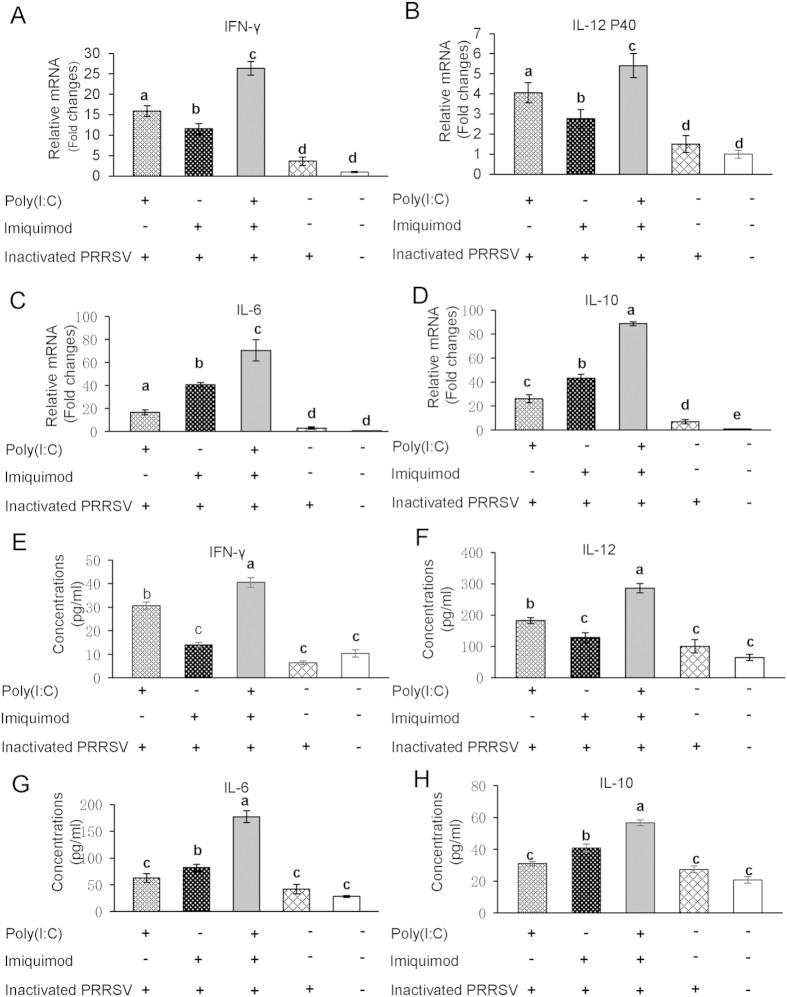
The mRNA and protein levels of cytokines in MoDCs stimulated with TLR ligands and inactivated PRRSV antigen.MoDCs were incubated with poly (I: C) and/or imiquimod along with inactivated PRRSV antigen for 12 h, the inactivated PRRSV antigen and RPMI-1640 were used as control. The transcript levels of Th1-type cytokines IFN-γ (A) and IL-12 P40 (B), Th2-type cytokines IL-6 (C) and IL-10 (D) were analyzed by real-time RT-PCR. Relative transcript levels are shown as fold changes relative to the level for the control cells of the RPMI-1640 group. Concentrations of Th1-type cytokines IFN-γ (E) and IL-12 (F), Th2-type cytokines IL-6 (G) and IL-10 (H) in the supernatants of MoDCs were detected by ELISA. The data represent the means of three independent experiments, with each experiment performed in triplicate. Data represent the means ± standard deviations (error bars) of three independent experiments. Different letters (a–e) mean significant difference (P < 0.05).